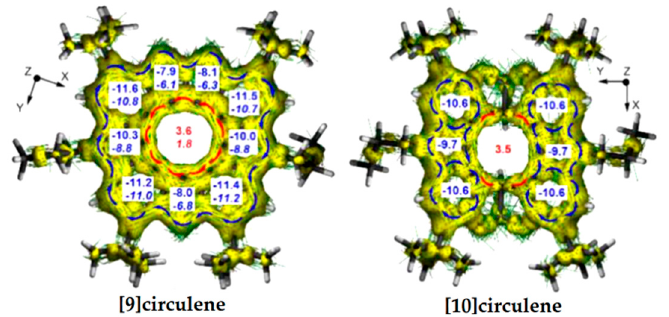
Figure 18. ACID plots. Blue arrows—local diatropic currents, red arrows—paratropic currents. The NICS(0) (top number) and NICS(1) (bottom number in italics) indices in the [9]circulene and [10]circulene calculated by the GIAO/B3LYP/6-311++G(d,p) method [99].